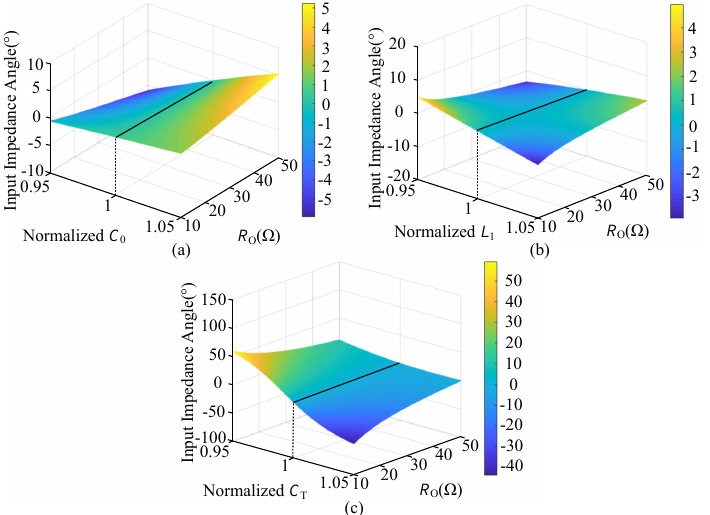
Figure 5. The input impedance angle versus different R O and normalized ( a ) C 0 , ( b ) L 1 and ( c ) C T